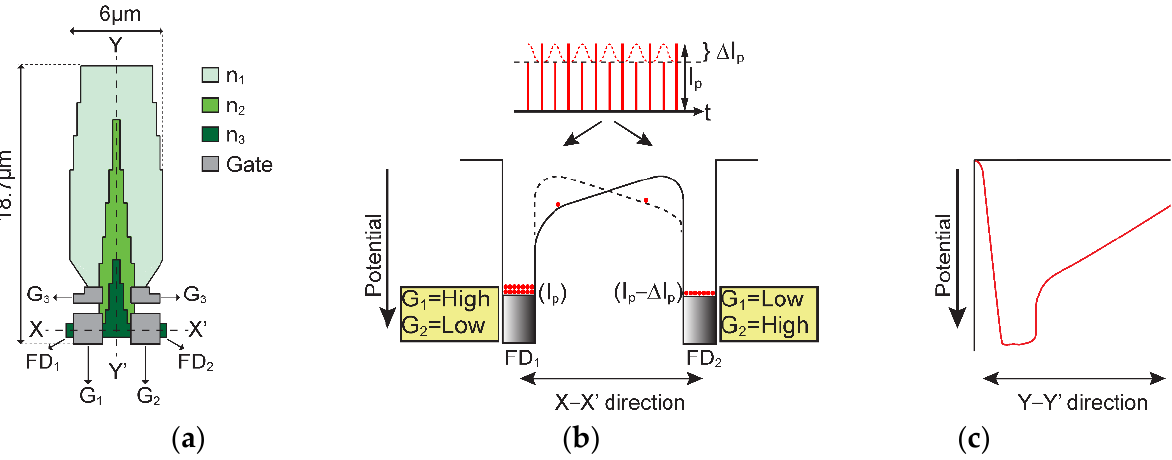
Figure 4. Three ‐ step ion implantations LEFM photo ‐ demodulator: ( a ) The structure of LEFM photo ‐ Figure 4. Three-step ion implantations LEFM photo-demodulator: ( a ) The structure of LEFM demodulator, ( b ) Potential profile of the photo ‐ electrons transfer mechanism in the LEFM photo ‐ demodulator at X − X’ direction, and ( c ) Potential profile at Y − Y’ direction.